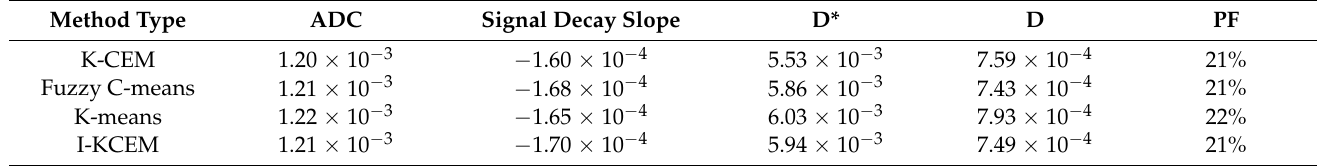
Figure 10. Signal-intensity decay of a mass tumor detected by the four methods using different b values in the third slice. Table 1 shows ADC, signal decay slope, D*, D, and PF parameter values for a mass tumor obtained by using different detection methods: K-CEM, fuzzy C-means, K-means, and I-KCEM. Table 1. Results of applying different detection methods to a mass tumor.